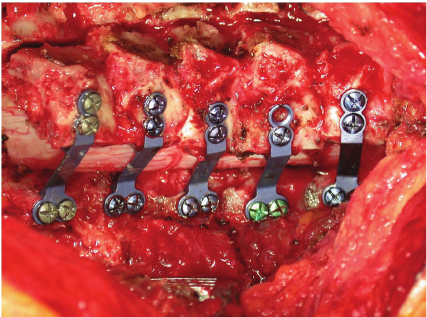
Figure 4: Post-laminoplasty view using plate fixation to hold the posterior hinge open.